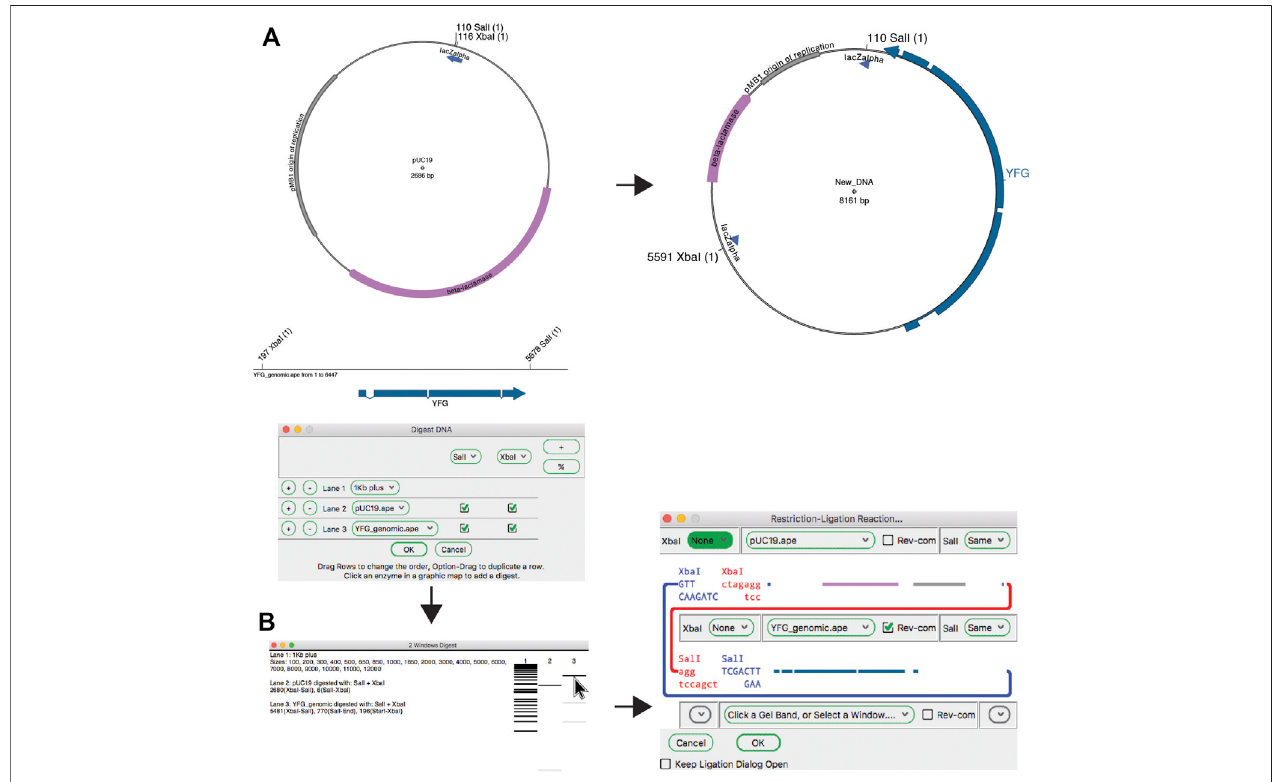
FIGURE 4 | The restriction-ligation assembler tool. (A) Graphic maps of the input sequence fi les for the planned reaction (left) and the product (right). (B) The Digestion Dialog is used to generate a virtual agarose gel of the two required DNA fragments: pU19 digested with XbaI and SalI, and a linear DNA fragment containing your favorite gene (YFG) digested with the same enzymes. The two fragments are then dragged into the Restriction-Ligation Assembler tool dialog. The tool then generates the product shown in (A) .